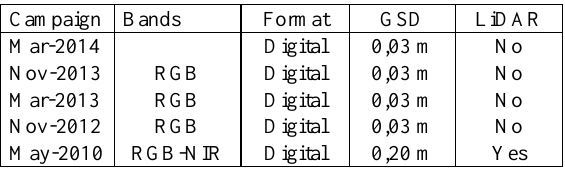
Table 1. Properties of datasets and flights.